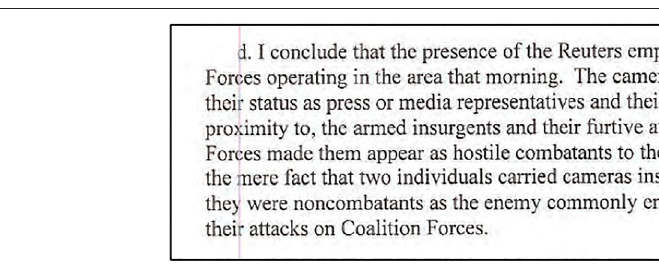
FIGURE 5 | Conclusions — Extract from the US military AR 15-16 investigation (Iraq, July 12, 2007).